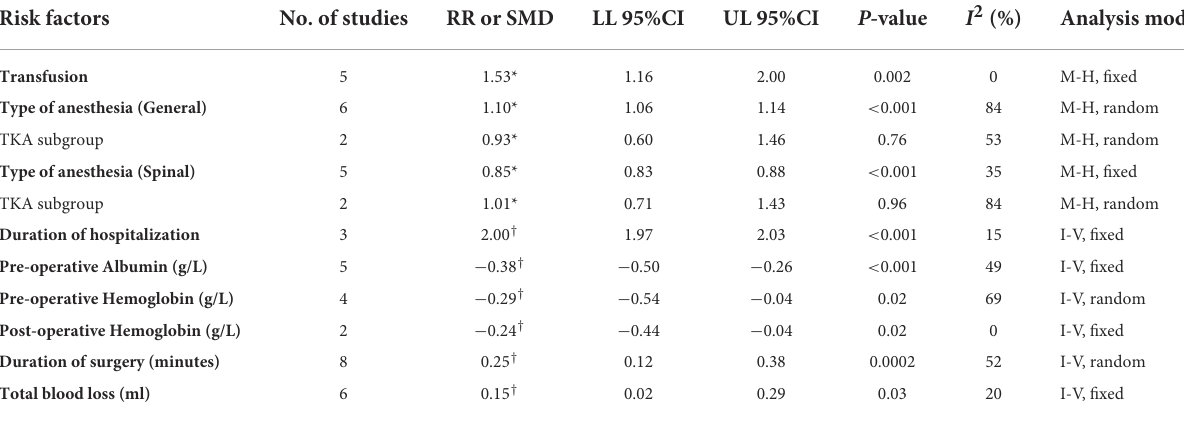
TABLE 5 The main outcomes of meta-analysis and subgroup analysis (surgical factors). Risk